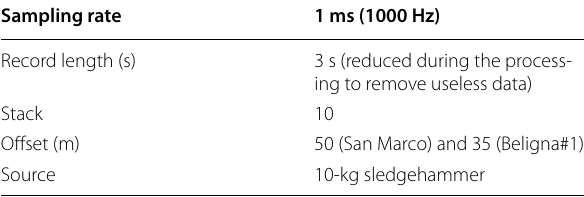
Table 1 Acquisition parameters for the HS (active) seismic